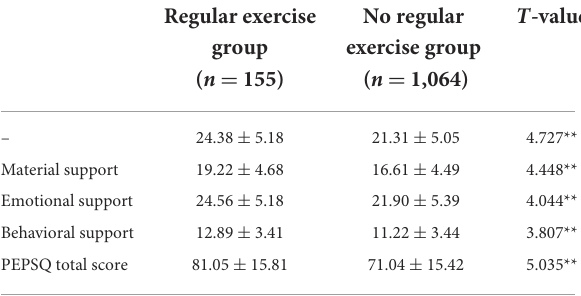
TABLE 11 Comparison of PEPSQ scores of different